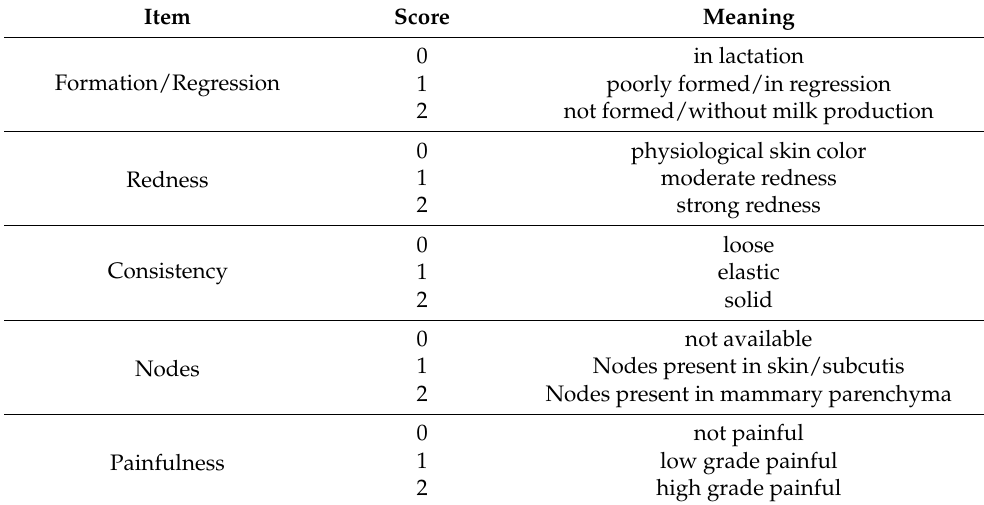
Table 2. Score sheet of the clinical examination of the